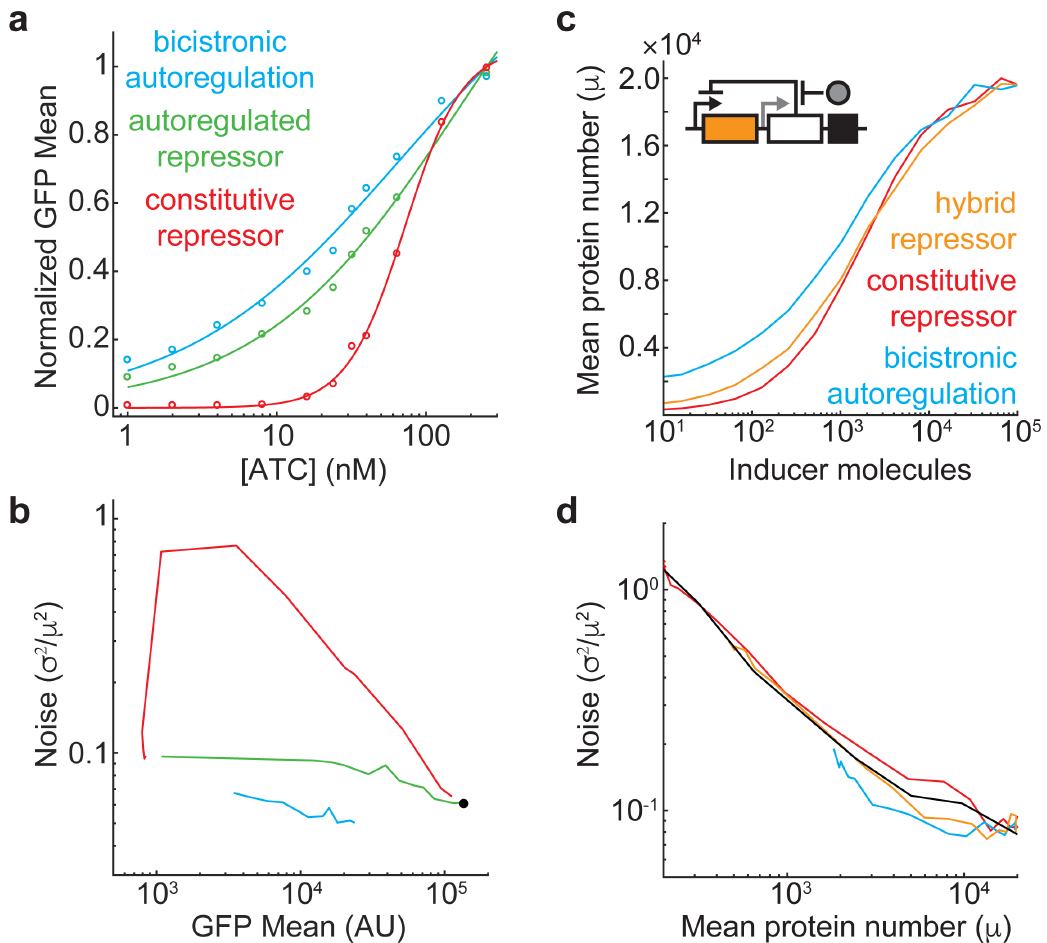
Fig 4. Comparison of regulatory circuits and increaseddynamic range with a hybrid circuit. ( A ) GFP inductionis measured by flow cytometry and fit using the Hill equation for pZH509 (blue, n h = 0.60 +/- 0.16), pZH517 (green, n h = 0.65 +/- 0.14) and pZH520 (red, n h = 2.24 +/- 0.22). Data and fit curves are normalized to the fit value at 256 nM ATc. Data not shown for 0 nM ATc ( Figure F in S1 Text). ( B ) Noise dependence on mean expressionlevel; coloringidenticalto Fig 4A . Black dot, pZH514 at 32 nM ATc. Noise cannot be calculatedfor pZH509 at 0 nM ATc because of low expression ( Figure F in S1 Text). ( C ) A hybrid scheme is proposed(inset) in which repressor (white box) expressionoccurs both from autoregulated (black arrow) and relativelyweak (gray arrow) promoters that share a transcription terminator (black box). This achievesan inducer dose-response in the gene of interested (orange)that is less steep than in the absenceof autoregulation (red) whileincreasing the dynamic range relative to bicistronic autoregulatory circuit (blue). ( D ) The hybrid system reducesnoise relativeto the system with constitutively expressedrepressor, with noise at or belowthe extrinsic limit (black). All simulations includeextrinsic